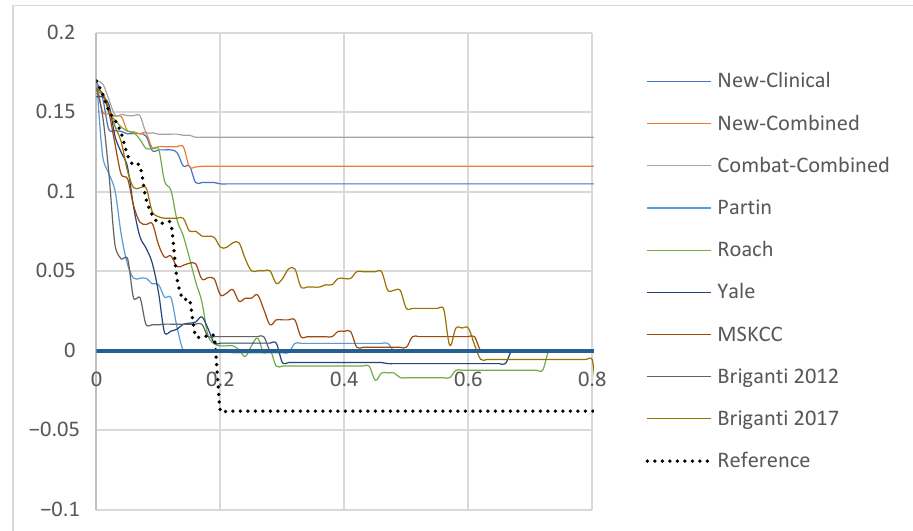
Figure 1. Decision curve analysis demonstrating the net benefit associated with use of the New-Clinical, New-Combined and ComBat-Combined Models for detection of lymph node invasion in comparison to currently available tools in the testing set (Partin, Yale, Roach, Briganti 2012, Briganti 2017 and MSKCC). x -axis: predicted probability, y -axis: clinical net benefit. Abbreviations: NN: Neural Network, MSKCC: Memorial Sloan Kettering Cancer Center.